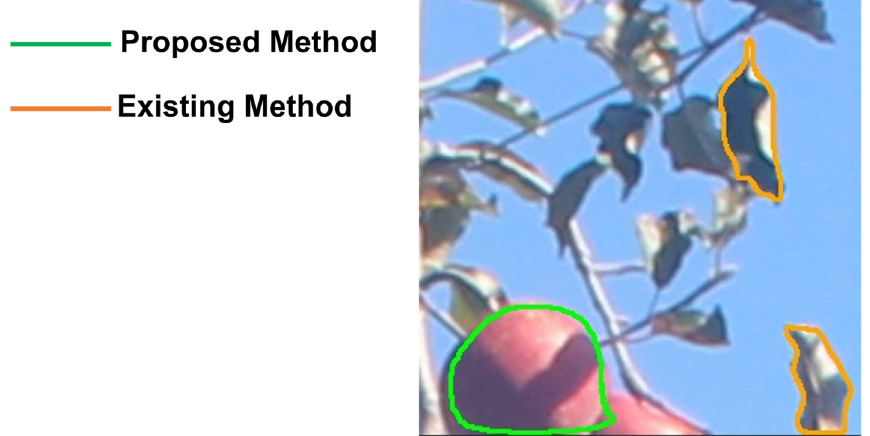
Figure 10. Example of a false detection. The orange line that is the result of the COCO learning model incorrectly detects leaves as fruit, while the green line that is the proposed model works correctly and does not incorrectly detect